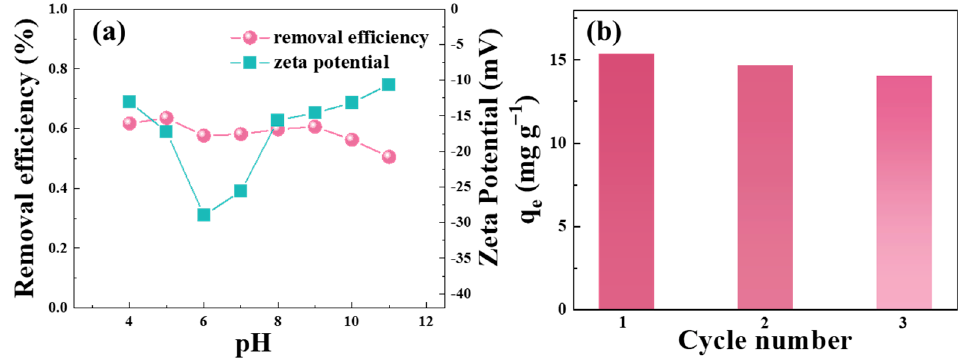
Figure 8. ( a ) Effect of pH value on MB adsorption onto PV-Cu-BTC; ( b ) PV-Cu-BTC on MB during